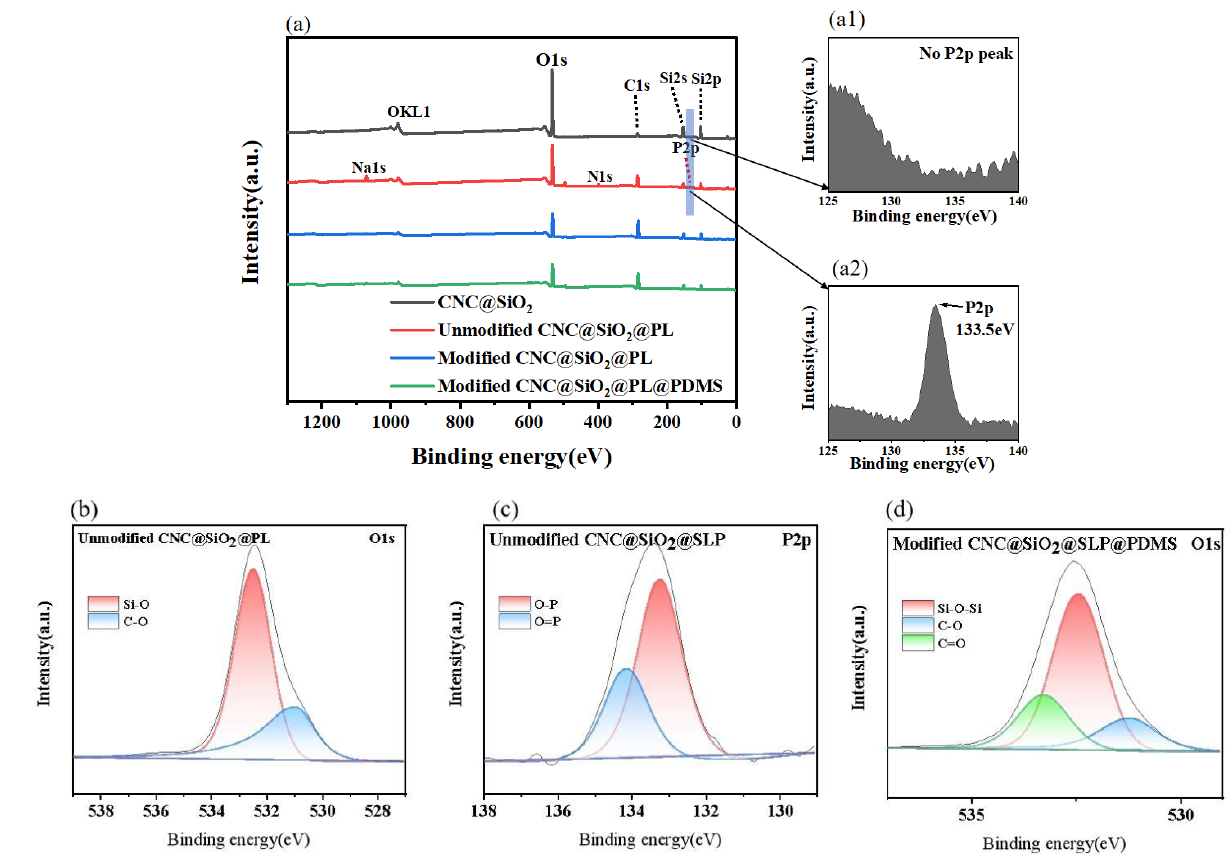
Figure 4. XPS spectra of ( a ) CNC@SiO 2 , CNC@SiO 2 @PL, modified CNC@SiO 2 @PL and